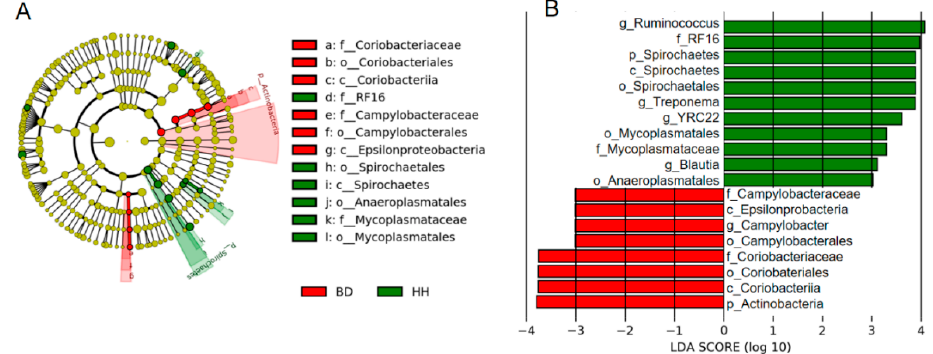
Figure 3. Linear discriminant analysis (LDA) effect size (LEfSe). ( A ) The cladogram diagram shows the microbiota with significant differences in the two groups. Red and green indicate different groups, with the species classification at the level of phylum, class, order, family, and genus shown from the inside to the outside. The red and green nodes in the phylogenetic tree represent microbial species that play an important role in the brisket disease group (BD) and healthy heifer group (HH), respectively. Yellow nodes represent species with no significant difference. ( B ) Microbiota with significant difference that have a LDA score greater than the estimated value; the threshold score is 3.0. The length of the histogram represents the LDA score, which compares the degree of influence of species with significant difference between groups.